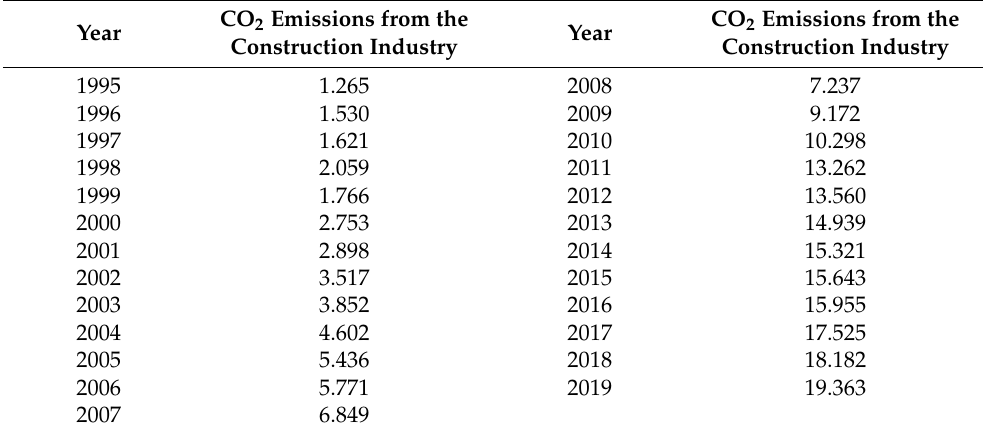
Table 5. Carbon emissions in China (billion